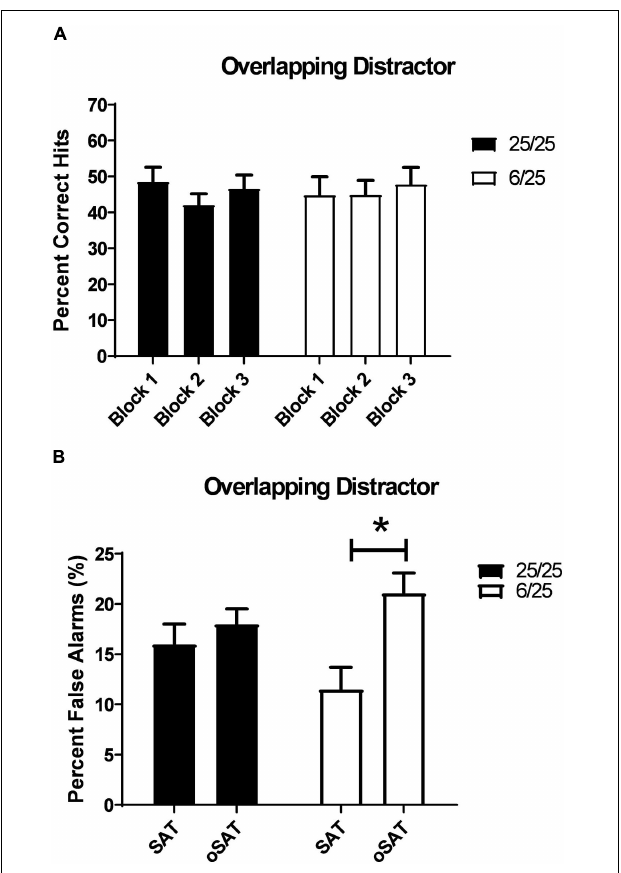
FIGURE 6 | (A) The effects of a distracting, visual stimulus that overlapped in duration with targets (500, 100, or 25 ms on/off; oSAT) is shown. All rats were impaired in signal detection during this session when performance was compared to the baseline. For comparison, see data in Figure 3B . This distractor produced similar deficits in all rats regardless of prenatal protein levels. (B) Prenatally malnourished rats (6/25, white bars) emitted a greater number of false alarms when the houselight was flashed at durations equivalent to that of target stimuli (oSAT) than when the houselight was constantly illuminated (SAT). Rats from well-nourished mothers (black bars) did not show significantly higher numbers of false alarms during the overlapping distractor session (oSAT) than during than baseline SAT with the houselight constantly illuminated (SAT). These data support the hypothesis that malnutrition contributes to impairments in response inhibition. ∗ indicates p <